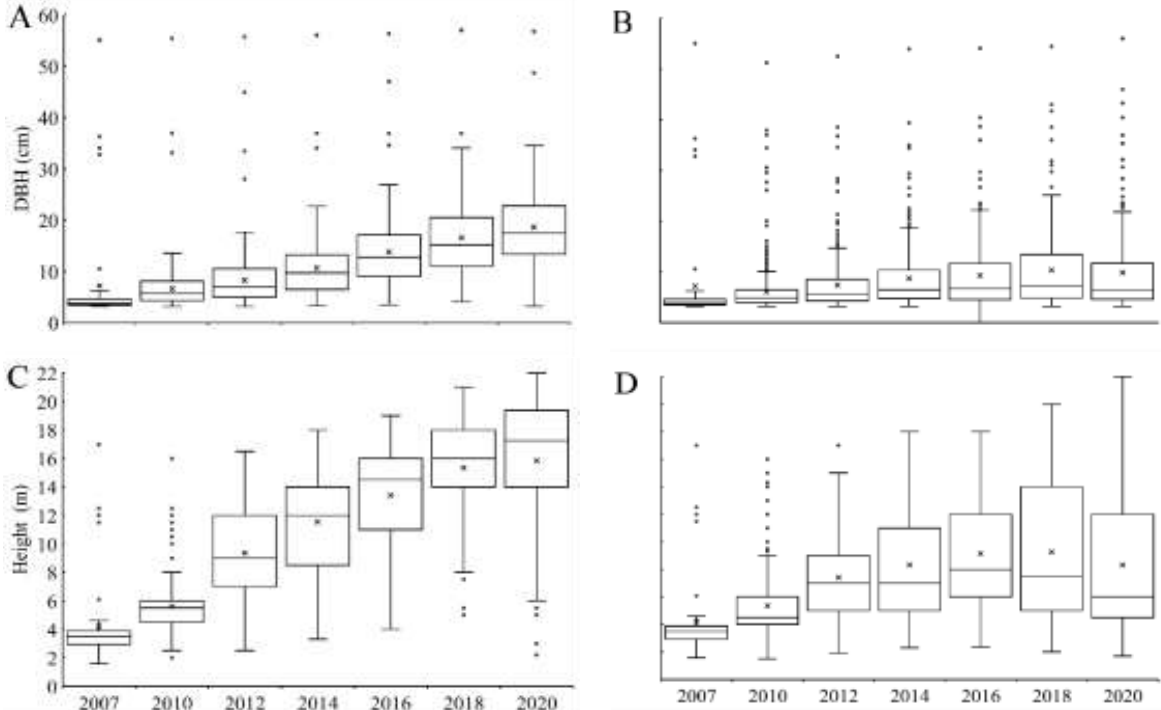
Figure 4. Population distribution based on DBH (m 2 ) and height (m) for control ( A , C ) and removal ( B , D ) between 2007 and 2020. X indicates the mean and O indicates outliers.